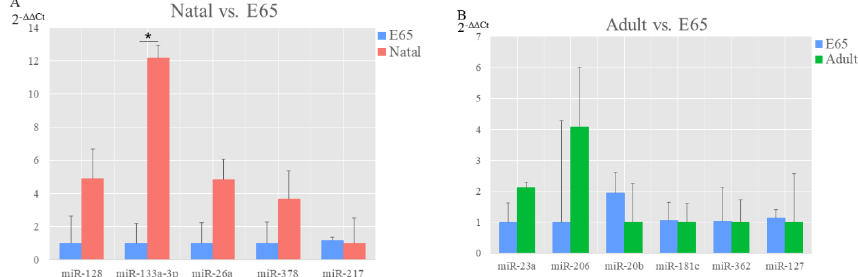
Figure 7. Validation of differentially expressed (DE) miRNA from three groups of pairwise comparisons by qRT-PCR (A: natal vs. E65 and B: adult vs. E65). Data presented in the y -axis indicate genes expression as determined by qRT-PCR. * p -value < 0.05; ** p -value < 0.01.